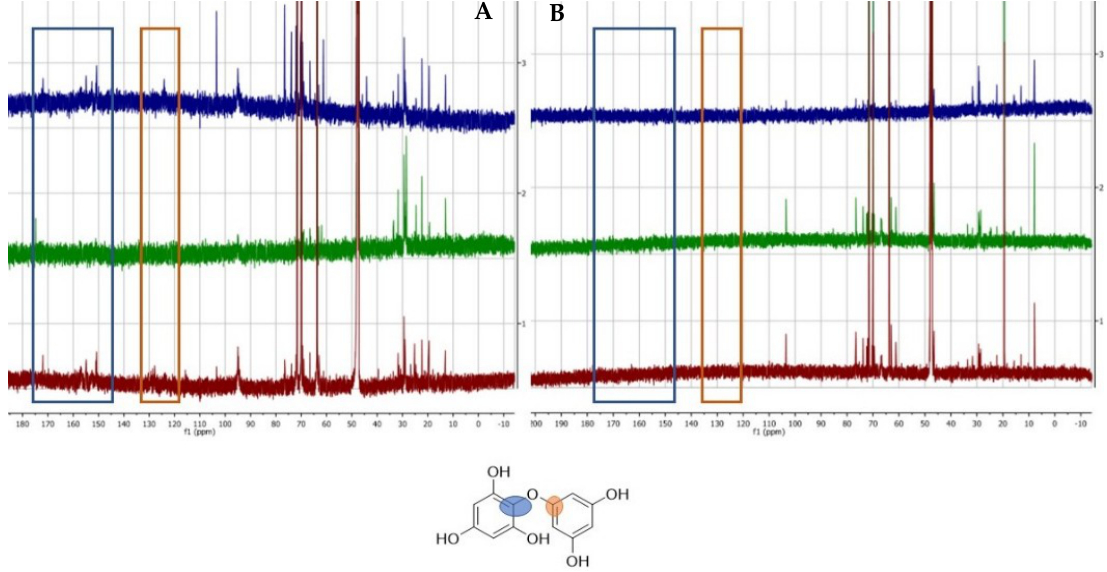
Species * Inoculant indicates the interaction of e ff ects. ND = not detected; L:A = lactic acid:acetic acid ratio. Means with di ff erent superscripts are significantly di ff erent ( p < 0.05); ns = no significant di ff erence; SEM = standard error of the mean.